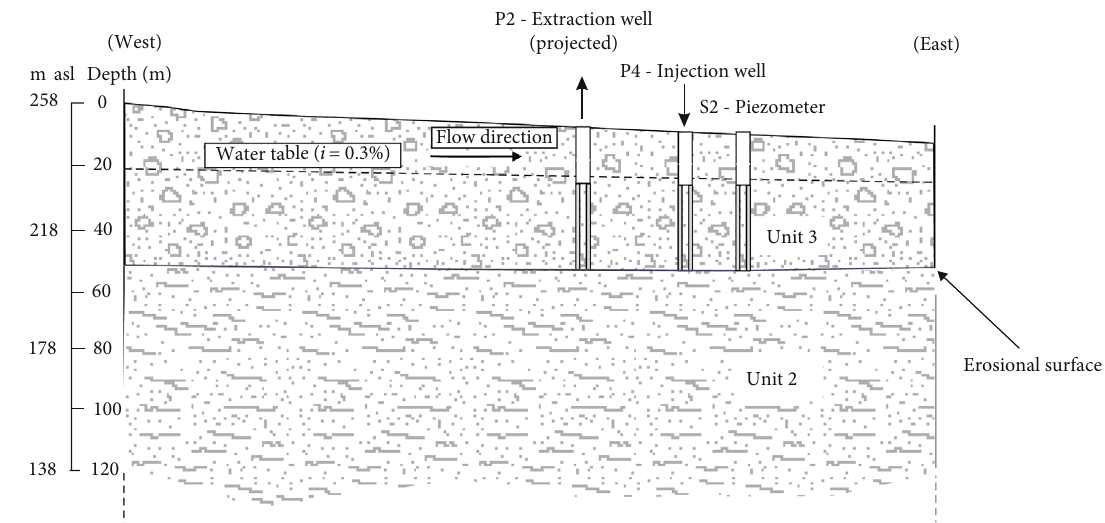
Figure 3: Schematic hydrogeological cross section of the study area [12]. Table 1: Nomenclature of thermal and hydrodynamic